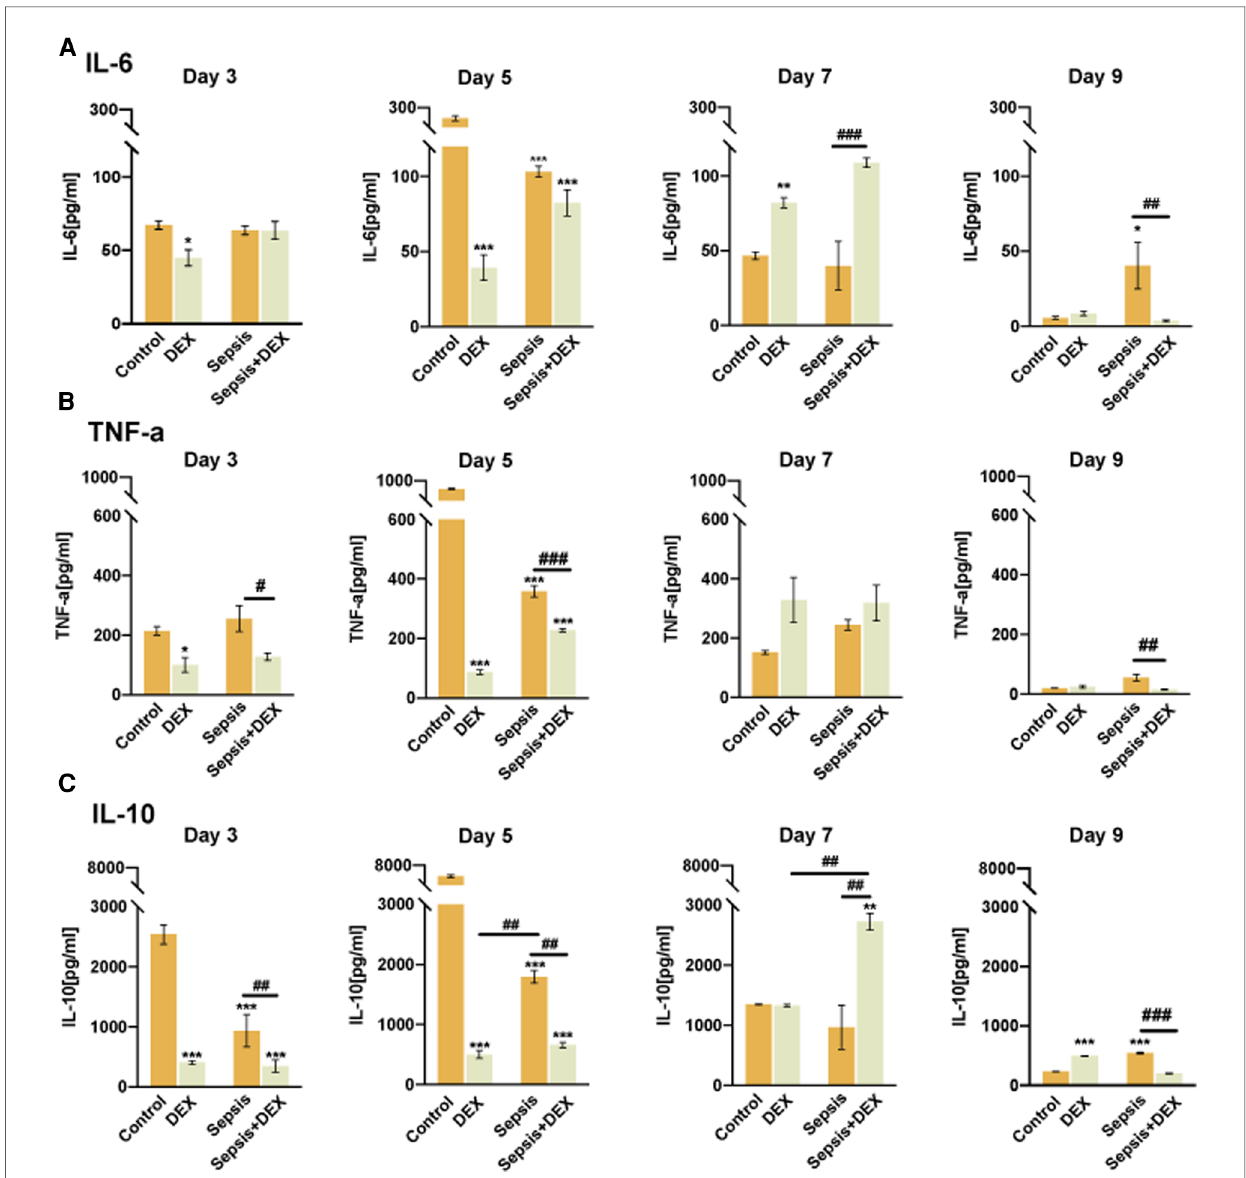
FIGURE 5 Intraperitoneal injection of dexamethasone impaired the initiation of in fl ammation in wounds of normal mice but not in septic mice. ELISA analysis of IL-6, TNF- α , and IL-10 in wounds. ( A ) The concentration of IL-6 in skin defects among control, DEX, sepsis, and sepsis+DEX groups on the 3 rd , 5 th , 7 th , and 9 th days after wounds creation. ( B ) TNF- α expression in tissue among the four groups on the 3 rd , 5 th , 7 th , and 9 th day after wounding. ( C ) IL-10 expression of wounds among different groups on the 3 rd , 5 th , 7 th , and 9 th day after the operation. All values represent mean±SEM, n =3.* P <0.05, ** P <0.01, *** P < 0.001, vs. control group; # P <0.05, ## P <0.01, ### P <0.001, vs. other groups. TNF- α , tumour necrosis factor- α ; ELISA, enzyme-linked immunosorbent